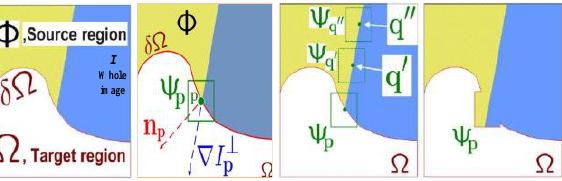
Figure 1. EBI notation diagram in [8]. Given the patch 𝜓 , 𝑛 is the normal to the contour 𝜕Ω of the 𝑝 𝑝 target region Ω and 𝛻𝐼 𝑝⊥ is the isophote (direction and intensity) at point 𝑝 . The entire image is denoted with 𝐼